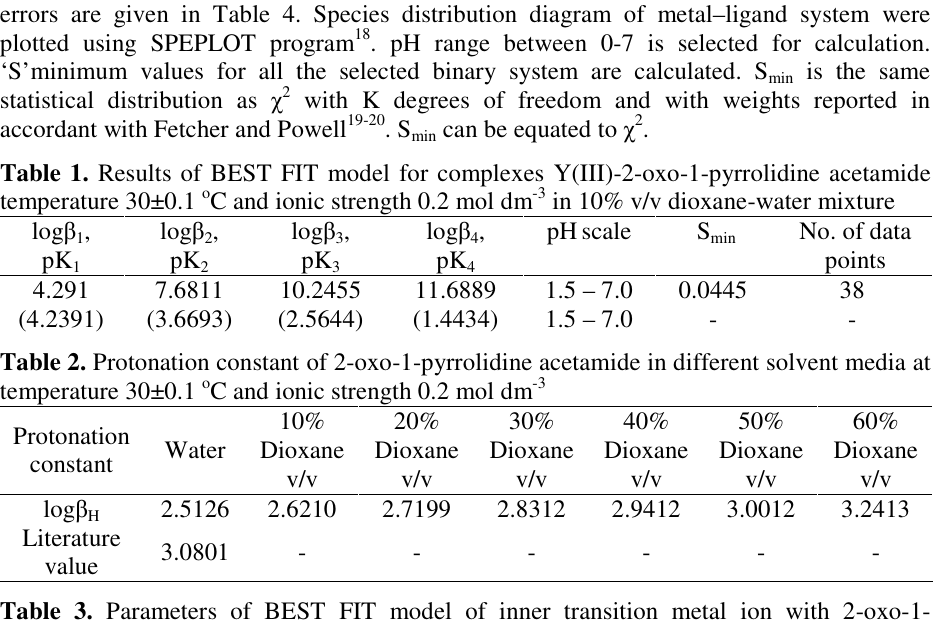
Table 3. Parameters of BEST FIT model of inner transition metal ion with